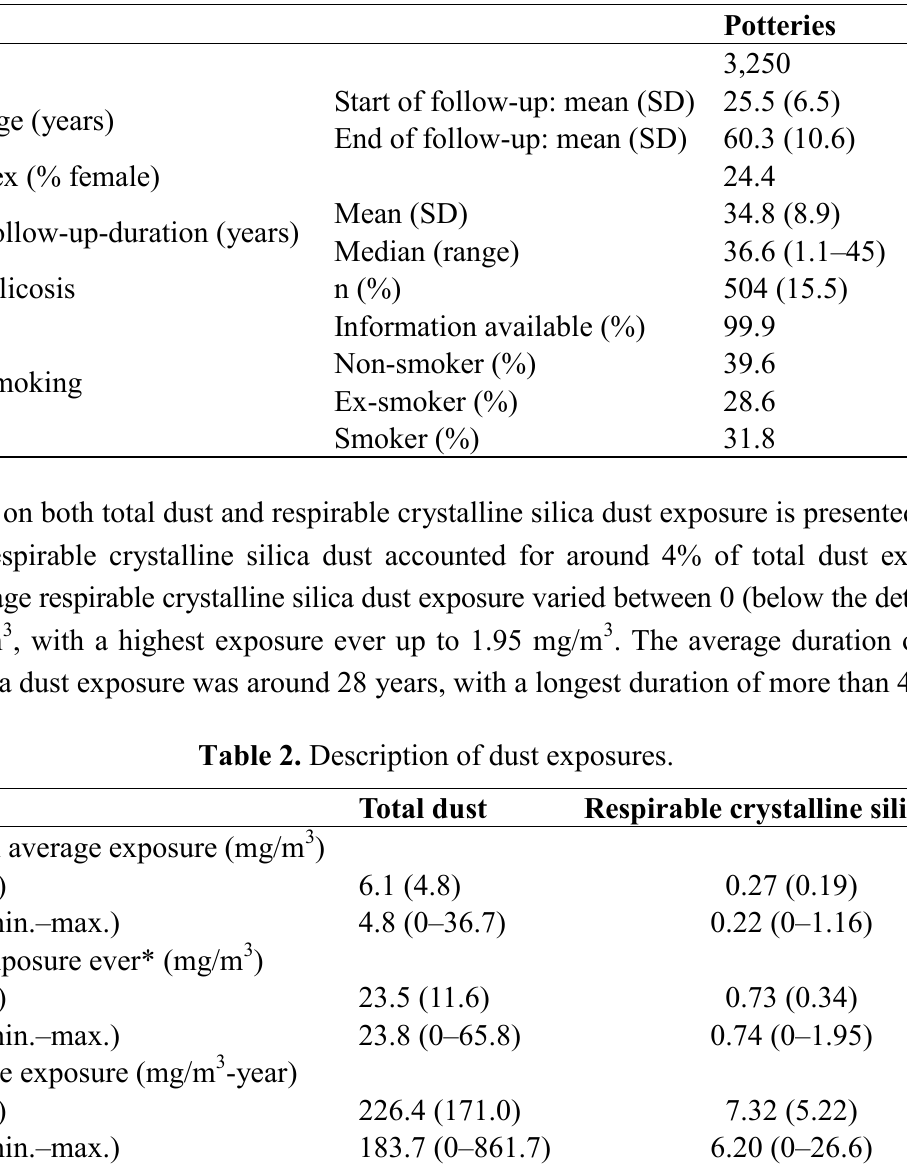
Table 1. Description of the study population.